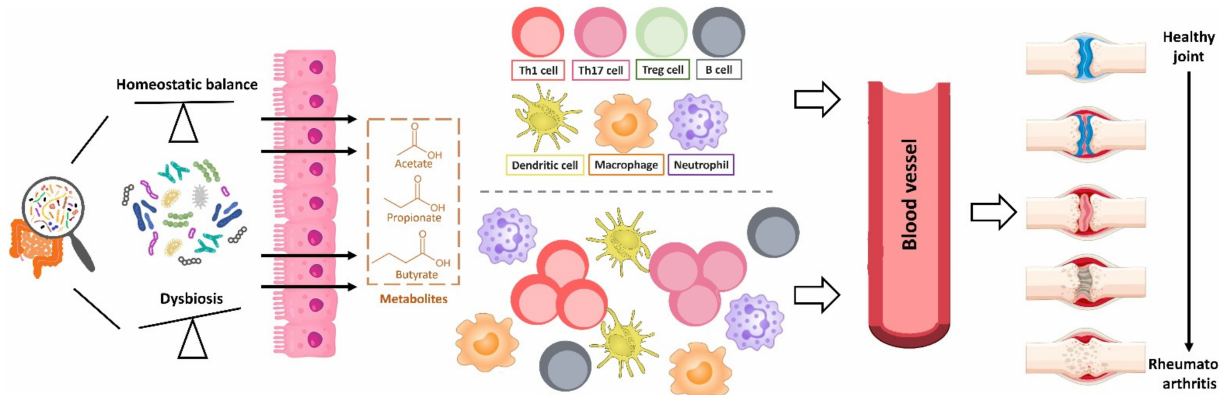
Figure 4. The critical roles of gut microbiota-modulated features in joint-associated colonic inflammation. Microbiota- mediated short-chain fatty acids (SCFA) modulate the risk of RA development and their potential effects on the innate immune cells (Dendritic cell, Macrophage and Neutrophil) or adaptive immune cells (Th1, Th17, Treg, and B cells). The outcome of gut microbiota dysregulation for the chronic inflammation in the joint tissue reflects the balance between pro- and anti-inflammatory mediators, and bacterial component translocation regulates the inflammatory response by enhancing Th1 and Th17 cell